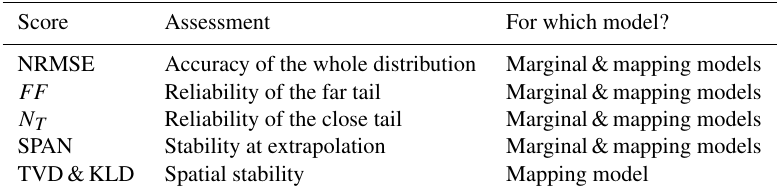
Table 2. Summary of the considered scores for evaluating marginal and mapping models. Score Assessment For which model? NRMSE Accuracy of the whole distribution Marginal&mapping models FF Reliability of the far tail Marginal&mapping models N T Reliability of the close tail Marginal&mapping models SPAN Stability at extrapolation Marginal&mapping models TVD&KLD Spatial stability Mapping